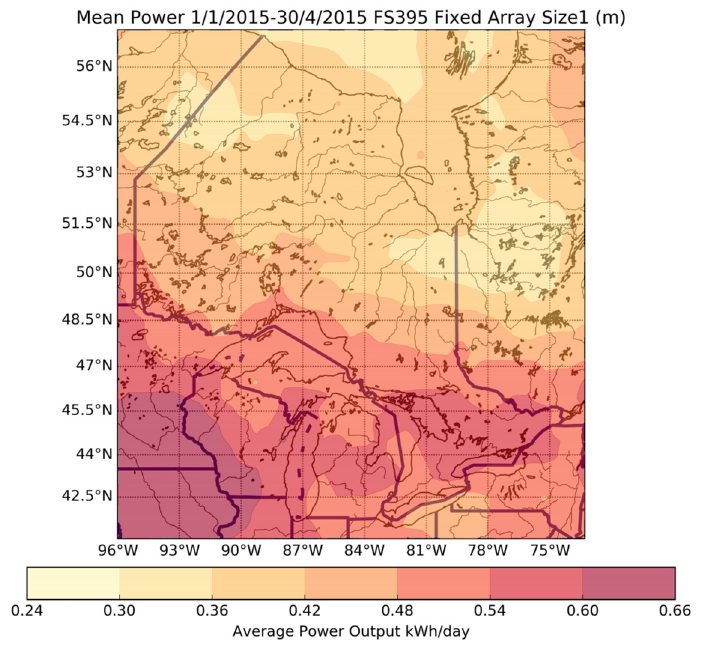
Figure 3. Example average solar power output for Ontario, Canada.